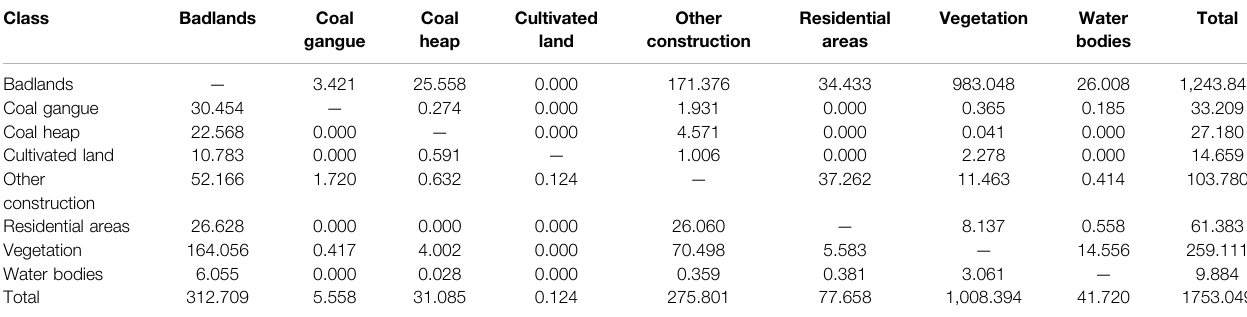
TABLE 10 | Land-use class change matrix from 2011 to 2018 (unit: 10 – 2 km 2 ).